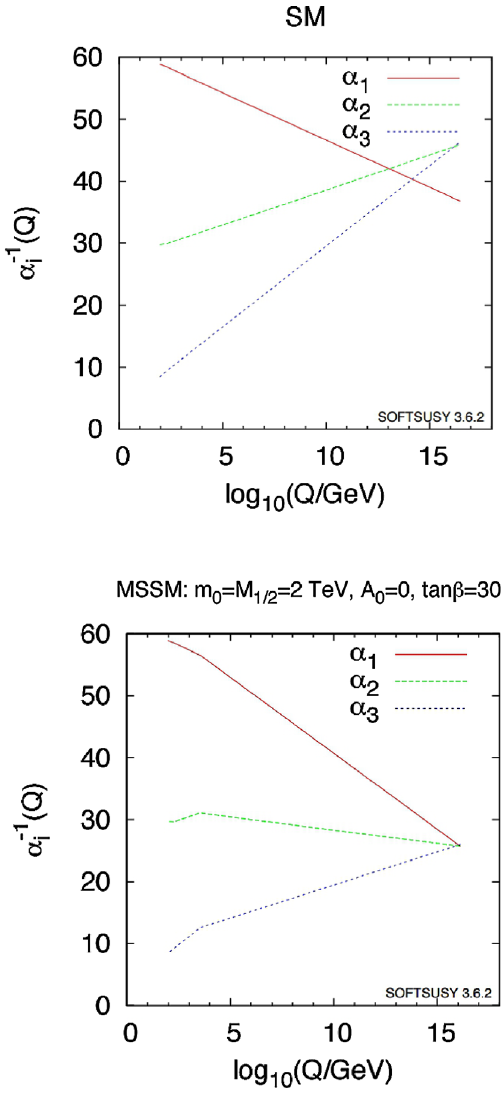
Fig. 1 Evolution of the coupling constants of U ( 1 ) , SU ( 2 ) and and SU ( 3 ) (color) groups as function of the momentum transfer